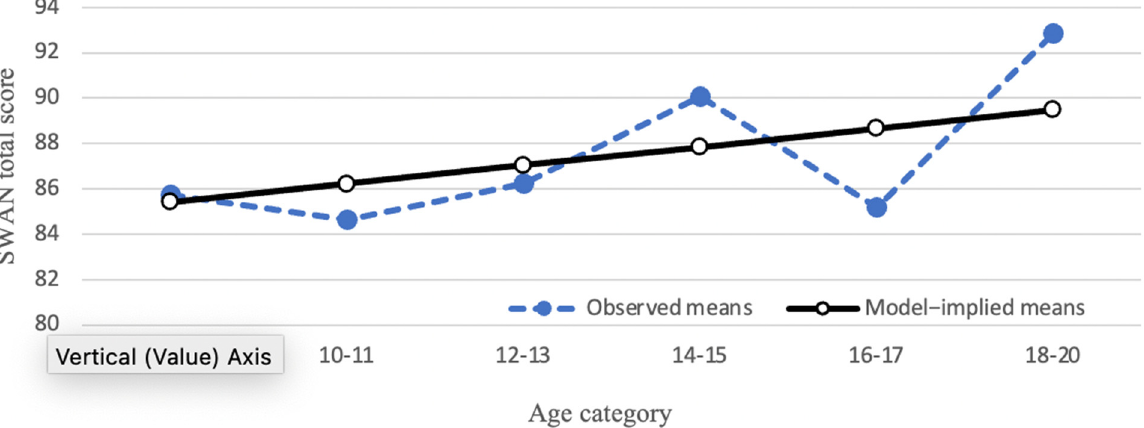
Figure 1. Developmental trajectory of SWAN total score. Closed circles represent observed means; open circles represent model-implied means.